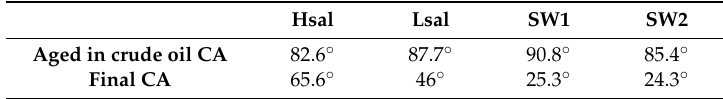
Table 5. Contact Angle values of Case 3 (neutral wet) calcite surfaces aged in crude oil and treated for two days in brine.